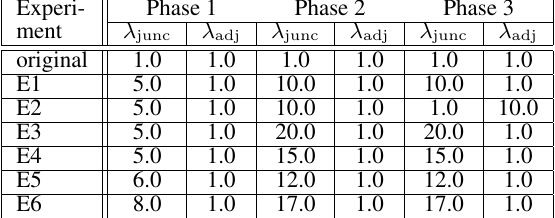
Table 1. Original (Zhang et al., 2019) and tested loss-function factors used in numbered experiments. Cases λ junc < λ adj